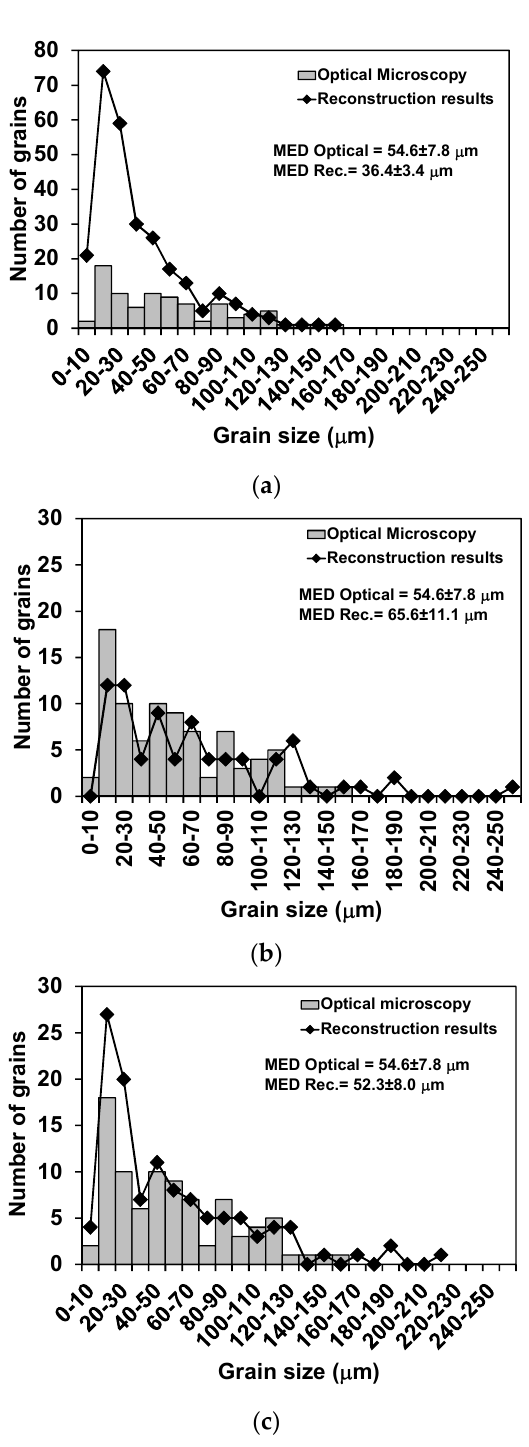
Figure 12 . Comparison of the MED measurements obtained from conventional metallography and the reconstruction procedure for the 1 μm step size scan using different criteria for twin boundary definition (4 μm minimum grain size): ( a ) All high angle (>10°) grain boundaries considered; ( b ) twins excluded (misorientation criterion (5° tolerance)); and ( c ) twins excluded (misorientation criterion (5° tolerance) + {111} plane coincidence criterion (1° tolerance angle).